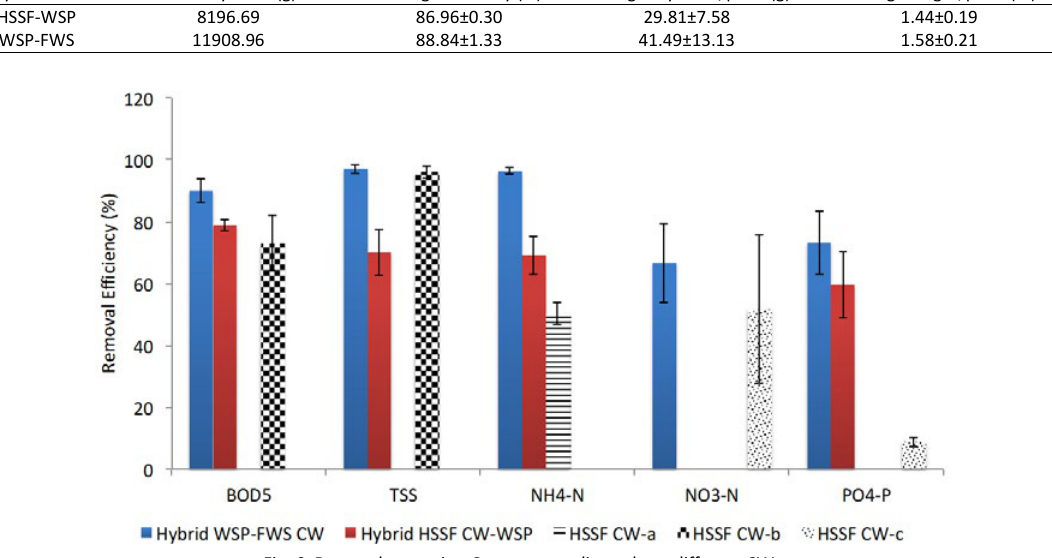
Fig. 6: Removal rate using Canna generalis reeds on different